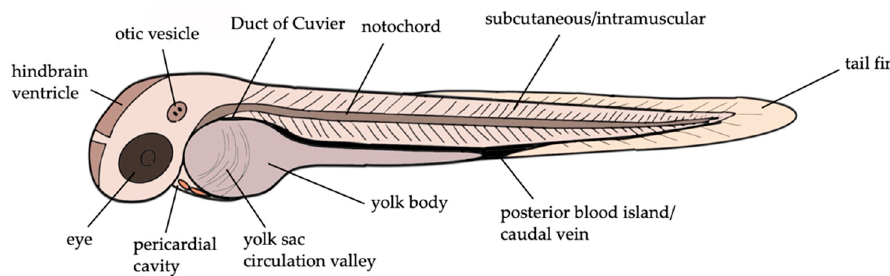
Figure 2. Injection sites of zebrafish larvae. Injection into the yolk sac circulation valley, Duct of Cuvier and the caudal vein leads to systemic infection, whereas injection into the yolk body, pericardial cavity, eye, otic vesicle and hindbrain ventricle results in local growth of bacteria. The figure was generated using SketchBook version 8.7.1.